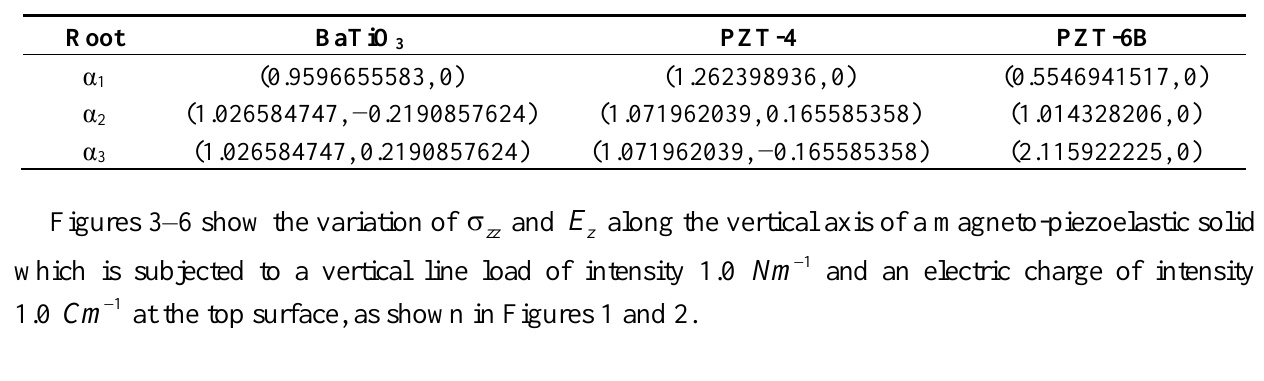
Table 2. Roots α 1 , α 2 ,, α 3 for Piezoelectric Materials from Table